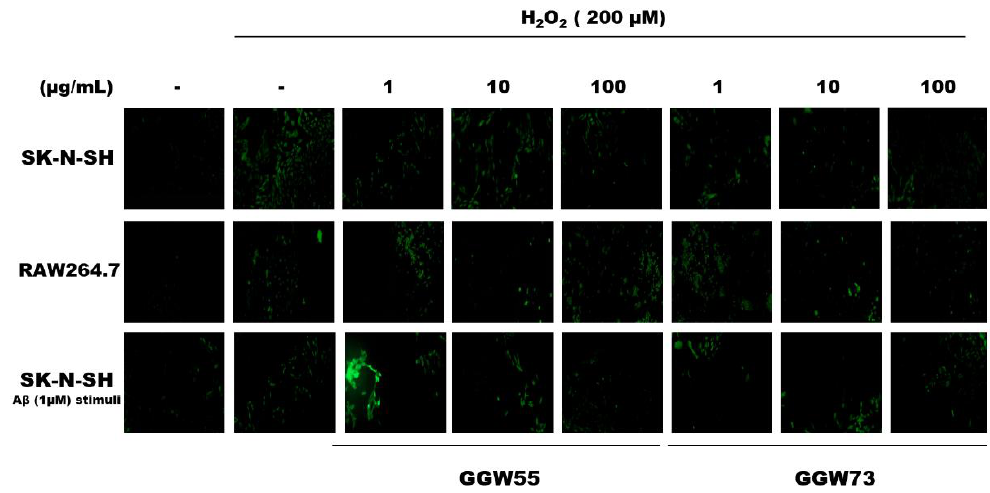
Figure 6. The regulatory effect of GGW55 and GGW73 on H 2 O 2 -stimulated ROS expression on SK-N-SH cell and RAW264.7. The fluorescent staining was observed with fluorescence microscope (100× magnification).